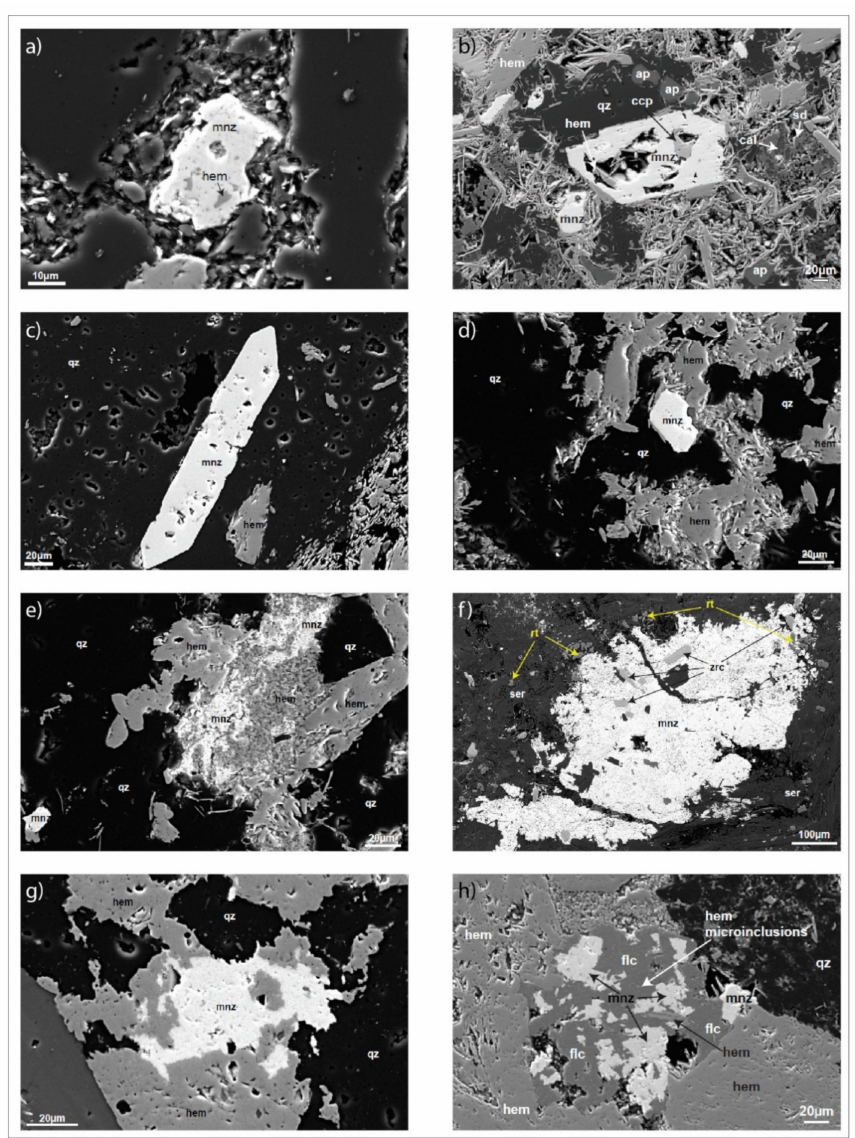
Figure 5. Representative SEM images of REE-bearing phases within basement and cover sequence samples in the Carrapateena deposit. ( a ) Euhedral monazite grain within a quartz grain in a hematite- rich clast (FIA_CAR091_34). ( b ) Euhedral monazite grain with hematite and chalcopyrite inclusions (CAR002_627). ( c ) Monazite grain containing hematite inclusions and preserved within the di- amictite matrix (FIA_CAR054_20). ( d ) Subhedral monazite grain within a hematite-quartz rich clast (FIA_CAR027_05). ( e ) Microgranular aggregates of monazite intergrown with hematite in a hematite-quartz rich clast (FIA_CAR027_05). ( f ) Microgranular monazite intergrown with zircon and rutile in a granite clast (FIA_CAR091_34). ( g ) Microgranular monazite intergrown with hematite (FIA_CAR058_14). ( h ) Large, anhedral monazite grains completely enclosed within florencite. Mon- azite and florencite preserve hematite inclusions and are preserved within a hematite breccia clast (FIA_CAR075_31). All images are secondary electron (SE) images. Sampled drillholes shown in Figure 3. Sample descriptions given in Table 1. Abbreviations: ap, apatite; cal, calcite; ccp, chal- copyrite; flc, florencite; hem, hematite; mnz, monazite; qz, quartz; rt, rutile; ser, sericite; sd, siderite; zrc,